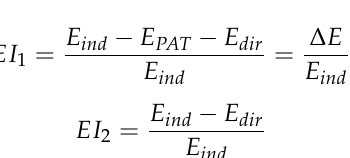
Figure 10. Time series of flow ( a ) and head loss ( b ) through the valve; pattern Δ(cid:1834),(cid:1843)((cid:1872)) ( c ).